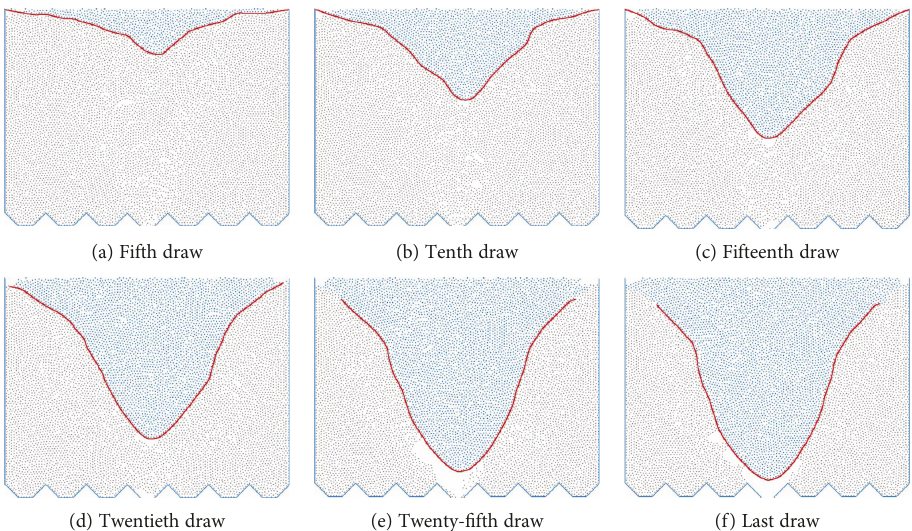
Figure 10: Dynamic subsidence graphs of the barrier